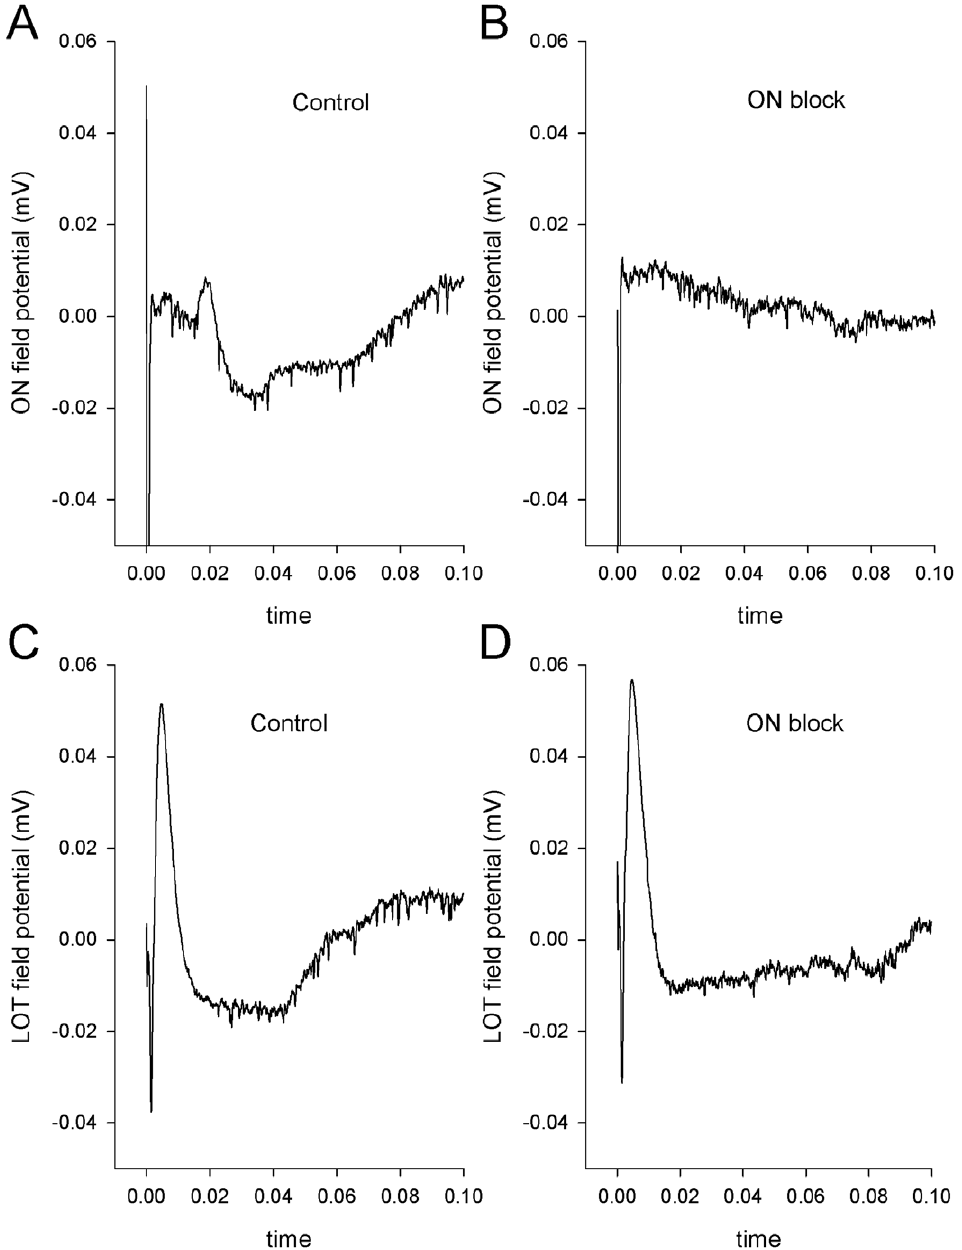
Figure 1. The effects of olfactory nerve block on field potentials. Field potentials recorded in the main olfactory bulb were evoked by stimulating the olfactory nerve (ON field potential, A and B) and the lateral olfactory tract (LOT field potential, C and D) before (control, A and C) and after (ON block, B and D) applying lidocaine to the olfactory nerve.